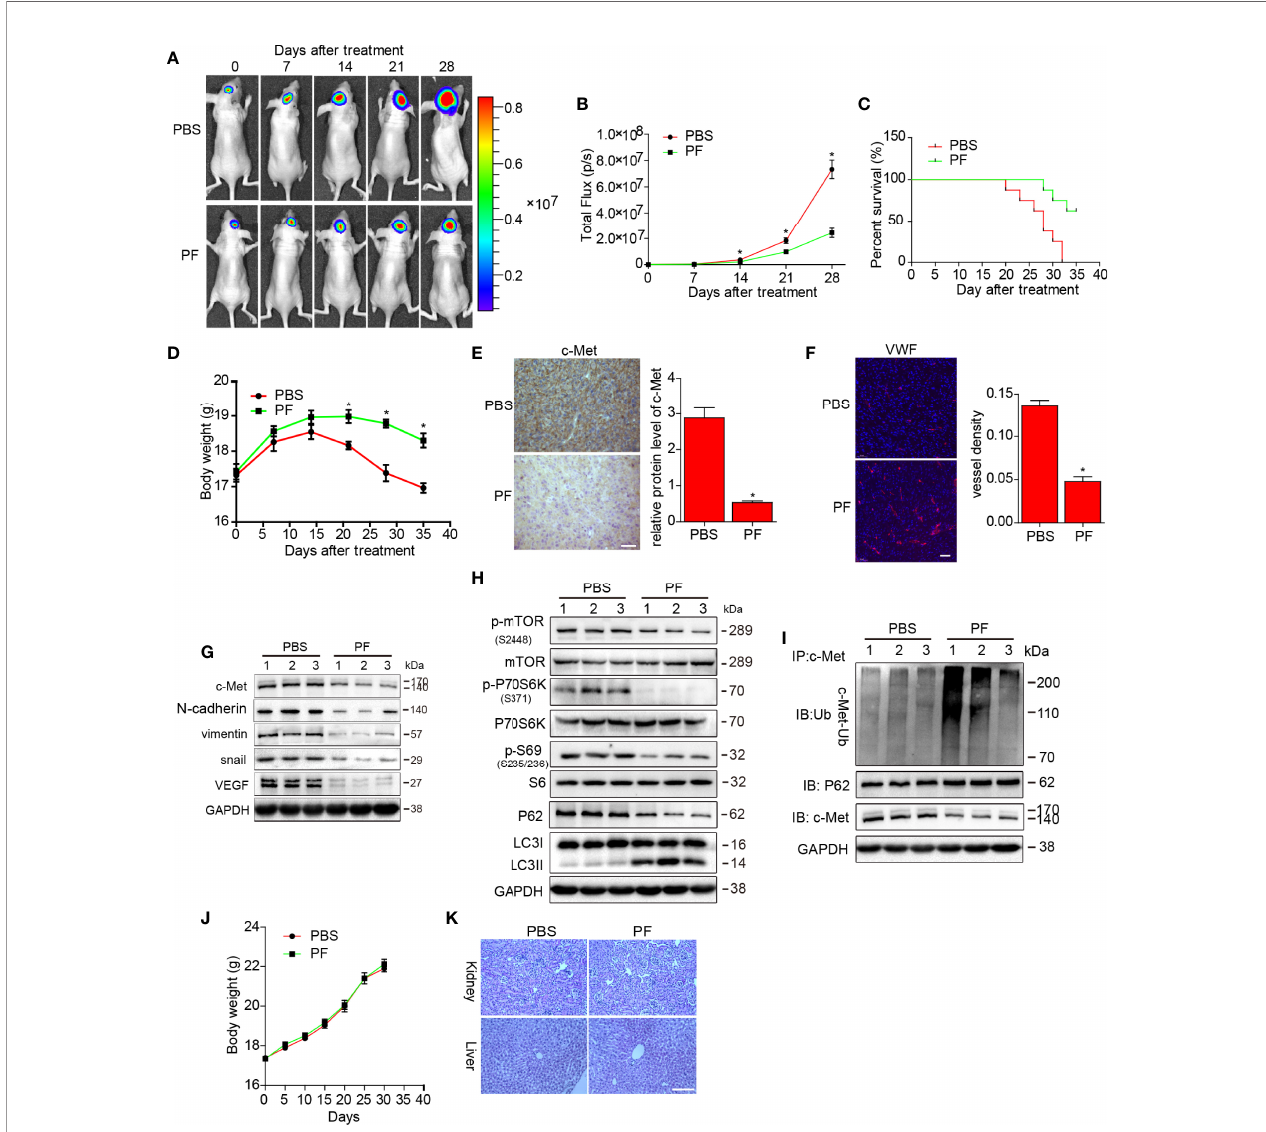
FIGURE 6 | Effects of paeoni fl orin on the orthotopic xenograft mouse model. U87-luciferace cells (1×10 6 ) were intracranially injected into the mid-right striatum of 6-week- old female BALB/c nude mice. Ten days post-injection, tumor formation was detected by bioluminescence imaging, and the mice were separated into the following two groups: a group comprising mice that were intraperitoneally injected with PPS (control) and a group comprising mice that were intraperitoneally injected with paeoni fl orin (400 mg/kg/day). Tumor sizes were measured once every 7 days. Bioluminescence imaging was used to measure tumor volumes. (A) A representative tumor volume in each group is shown at each time point (B) Tumor volumes were examined at each time point in each group. (C) The survival rate of each group. (D) Body weight changes in each group. At the end of the experiment or after the mice had died, the brains were excised (E) and were stained for c-Met (Bar, 20 m m) and (F) VWF (Bar, 50 m m). The images were analyzed by Image-Pro-Plus. At the end of the experiment or after the mice had died, the tumor tissues were excised, and the protein lysates (G) were used to estimate c-Met, VEGF and EMT markers expression; (H) mTOR/P70S6K/s6 signaling pathway expression; and autophagy-related protein (p62 and LC3) expression by western blotting. (I) The lysates were immunoprecipitated with anti-c-Met antibody and immunoblotted with antibodies against c-Met and p62. Normal mice were treated PBS or paeoni fl orin (400/kg/day) (for each group n=5) for 30 days (J) and the body weights were recorded (K) after 30 days, the kidney and liver tissues were obtained and HE-stained (Bar, 500 m m). * P <0.05, compared with